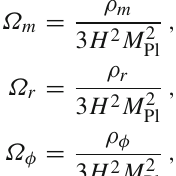
Big Bang Nucleosynthesis (BBN) yields another con- straint on the scalar inflaton